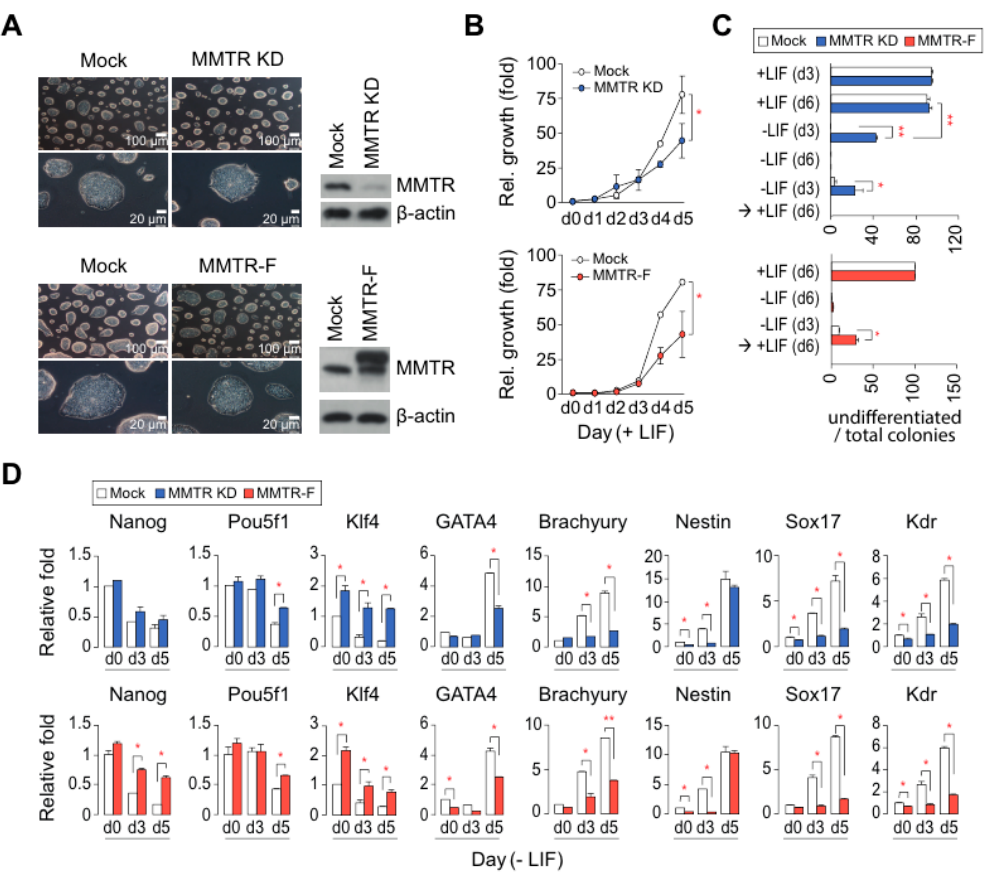
Figure 1. Establishment and characterization of Mat1 -mediated transcriptional repressor (MMTR)